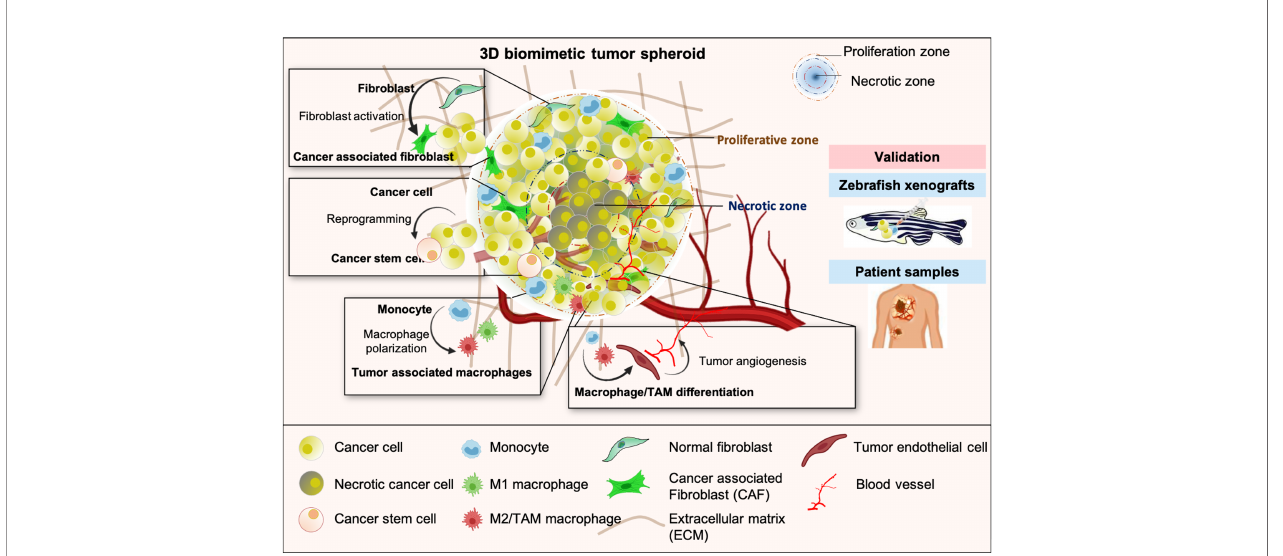
GRAPHICAL ABSTRACT | Schematic representation of multicellular 3D tumor spheroid with distinct proliferative and necrotic zones exhibiting key features of TME such as heterogeneity, cancer cell reprogramming and stemness, aggressive phenotype, alteration of stromal cells plasticity, and tumor angiogenesis. Results obtained from the study of 3D tumor spheroids were validated in the in-vivo experiments with zebra fi sh tumor xenograft model and lung cancer patients tissue